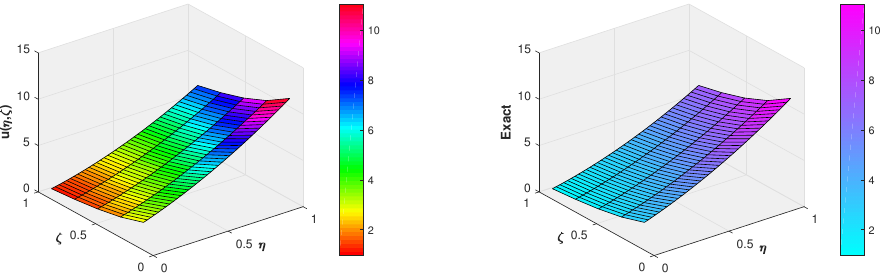
Figure 5. Three-dimensional comparison of the approximate and exact solutions at k = 4, M = 5 of Example 2.